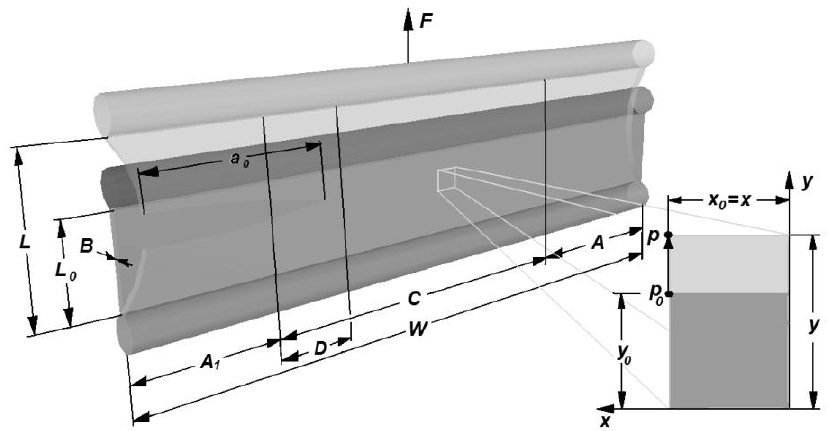
Figure 2. Schematic representation of a pure shear sample with depiction of the regions having different stress conditions (according to Reference [25]).